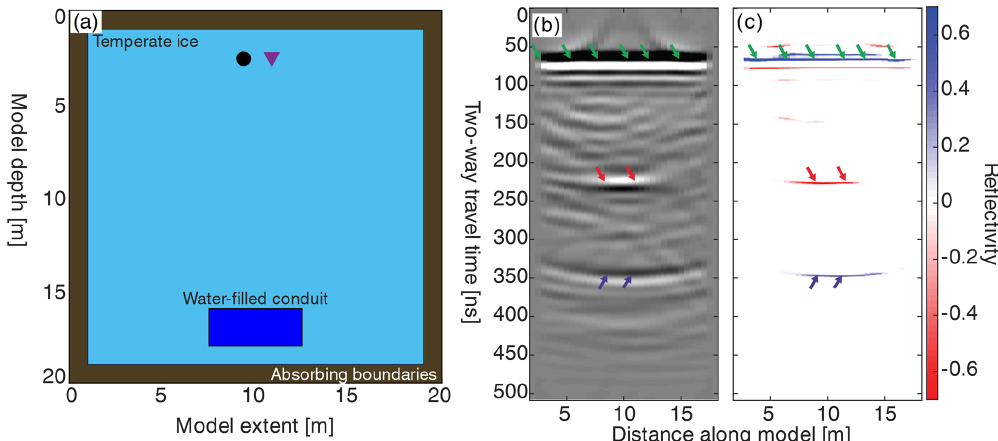
Figure 7. Forward modelling results. (a) Geometry model for gprMax forward modelling with temperate ice, a 2m thick water-filled conduit, and absorbing boundaries labelled. The circle and the triangle represent the transmitting and receiving antennas. (b) The processed synthetic data generated from the model in (a) after step 10 in Table 2. (c) The reflectivity from the data (b) after processing through the entire workflow described in Table 2. The green arrows represent the direct arrival, and the red and blue arrows represent the top and bottom reflections from the englacial conduit respectively.